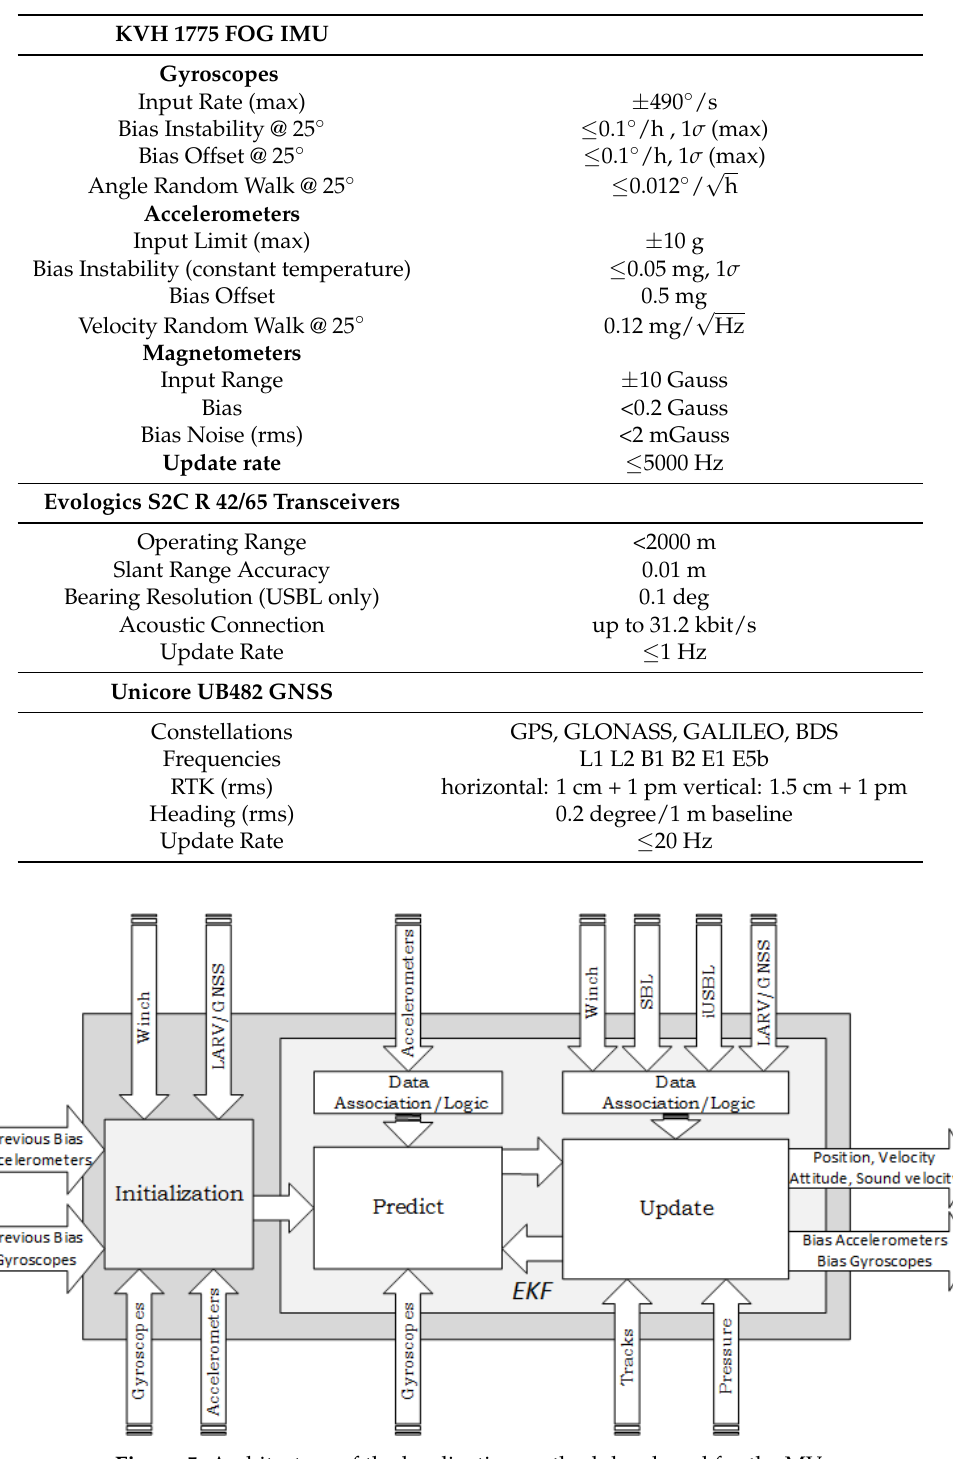
Table 1. Technical specifications associated with the IMU, installed on board the MV, and the acoustic positioning transceivers and the GNSS receivers, installed on the LARV.